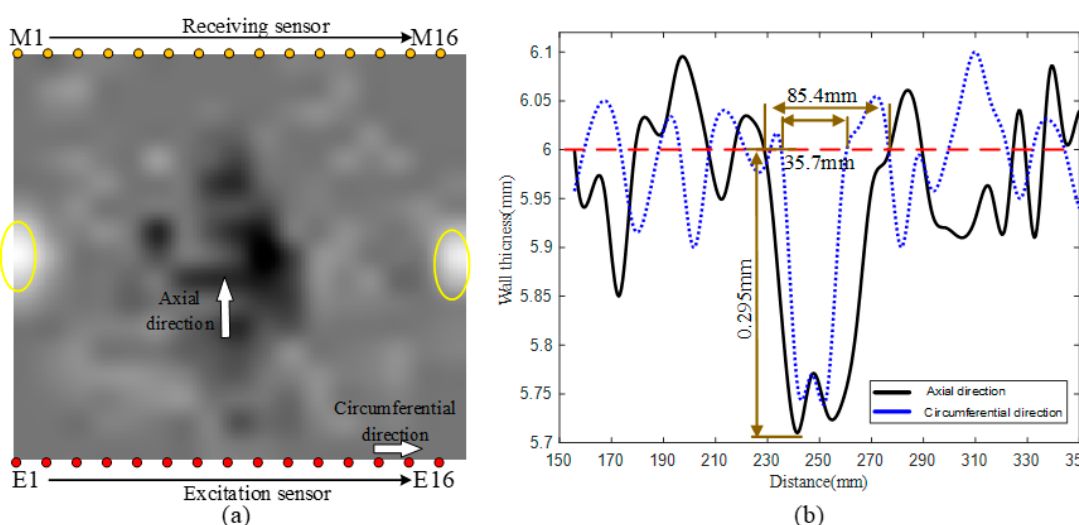
Figure 13. Quantitative curve of defect.